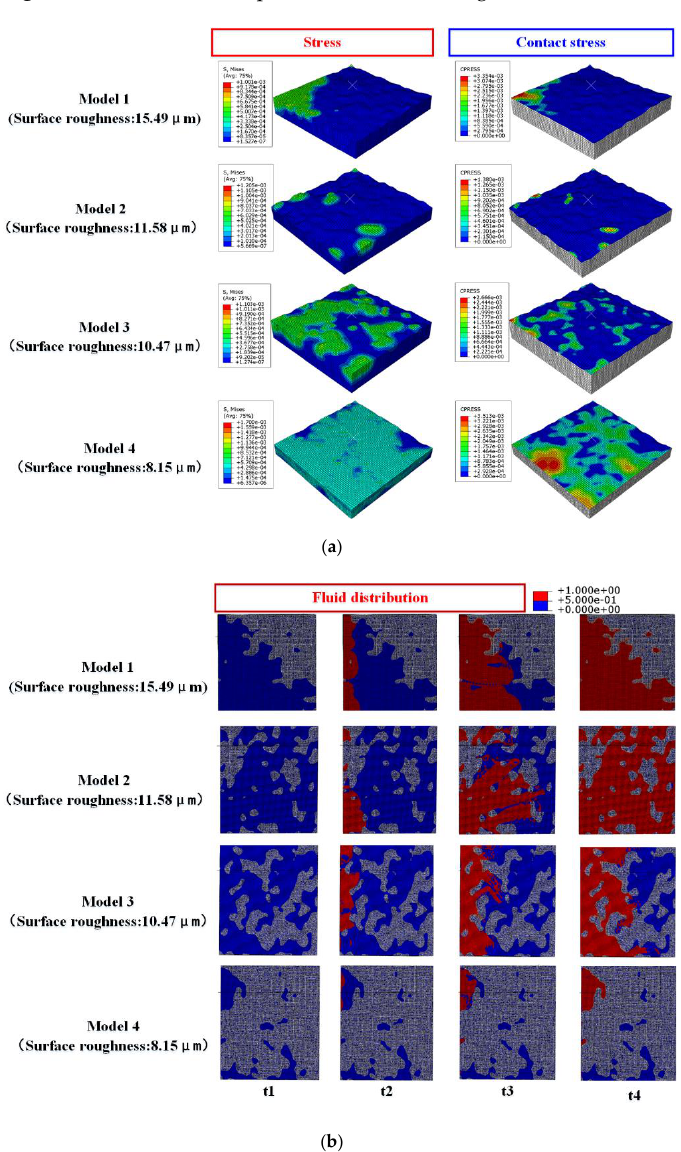
Figure 13. The gasket stress, contact stress, and medium flow characteristics of different surface roughness models: ( a ) gasket stress, contact stress distribution, ( b ) medium flow characteristics.